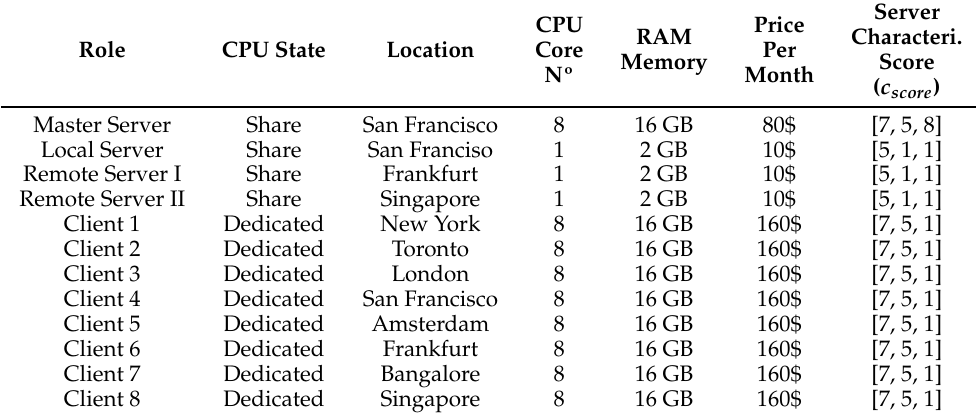
Table 11. Hired servers used during